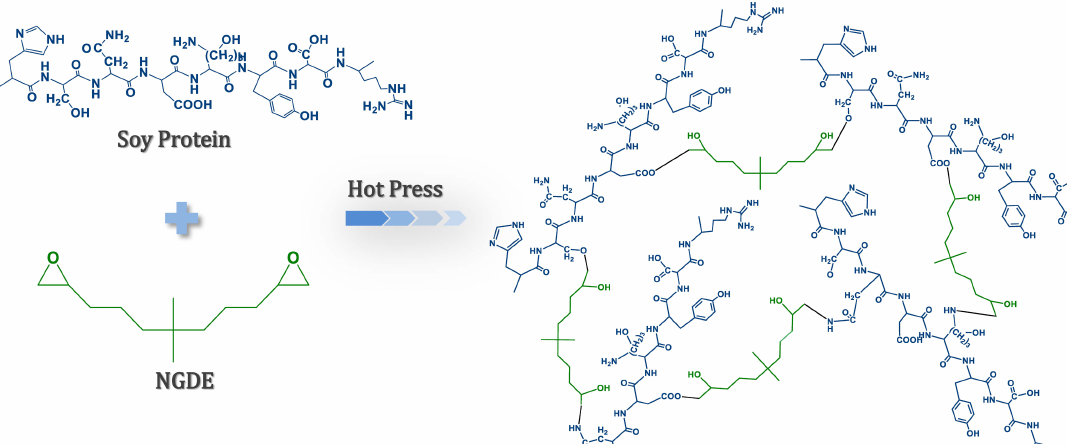
Figure 2. The curing process of the soy-based adhesive enhanced with NGDE.